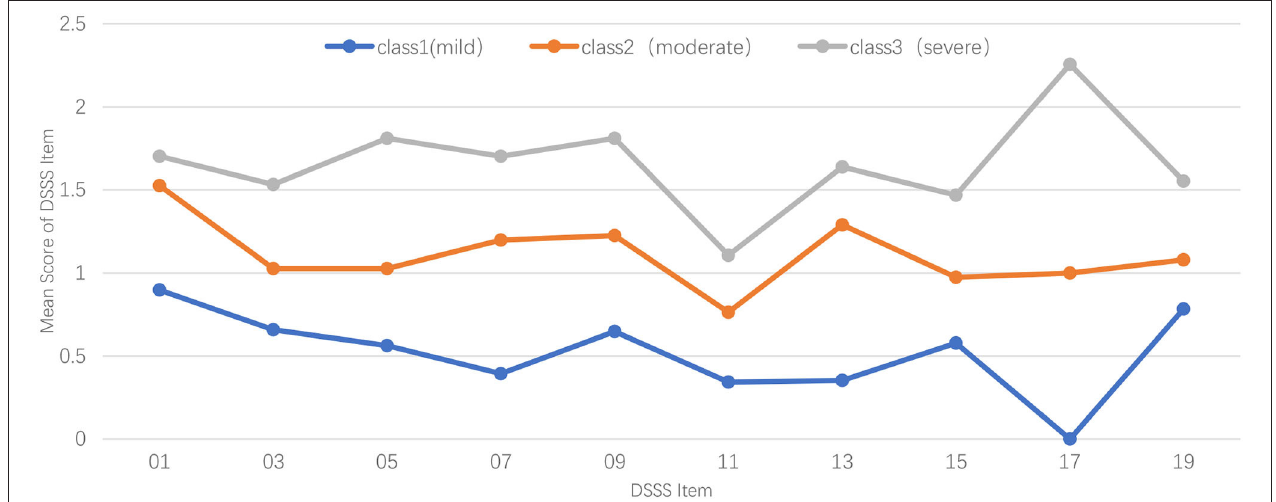
FIGURE 1 | Profiles of latent profile analysis of major depressive disorder by somatic